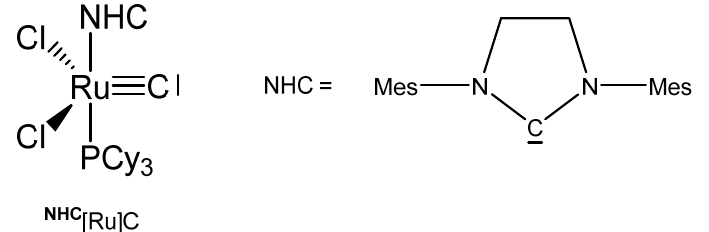
Figure 23. The NHC [Ru]C